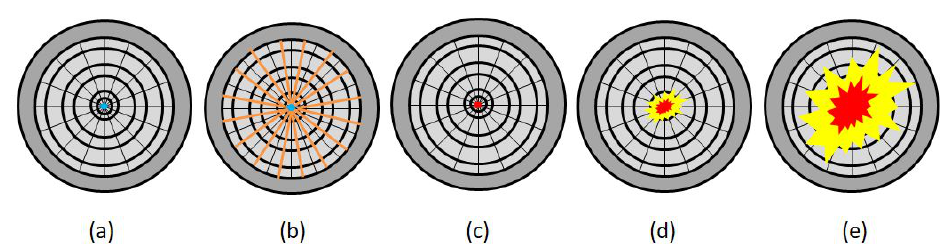
Figure 1. Illustration of engine reaction chamber. ( a ) Capsule target is accelerated onto central axis, ( b ) energy drivers target the capsule for a symmetry implosion, ( c ) some form of hot spot thermonu- clear ignition occurs, ( d ) a self-sustaining burn wave is initiated with alpha-particle deposition to ignite surrounding fuel, ( e ) plasma expansion into the reaction chamber with neutron and x-ray deposition into structure and space, and with the charged plasma debris exhausted for the purposes of thrust